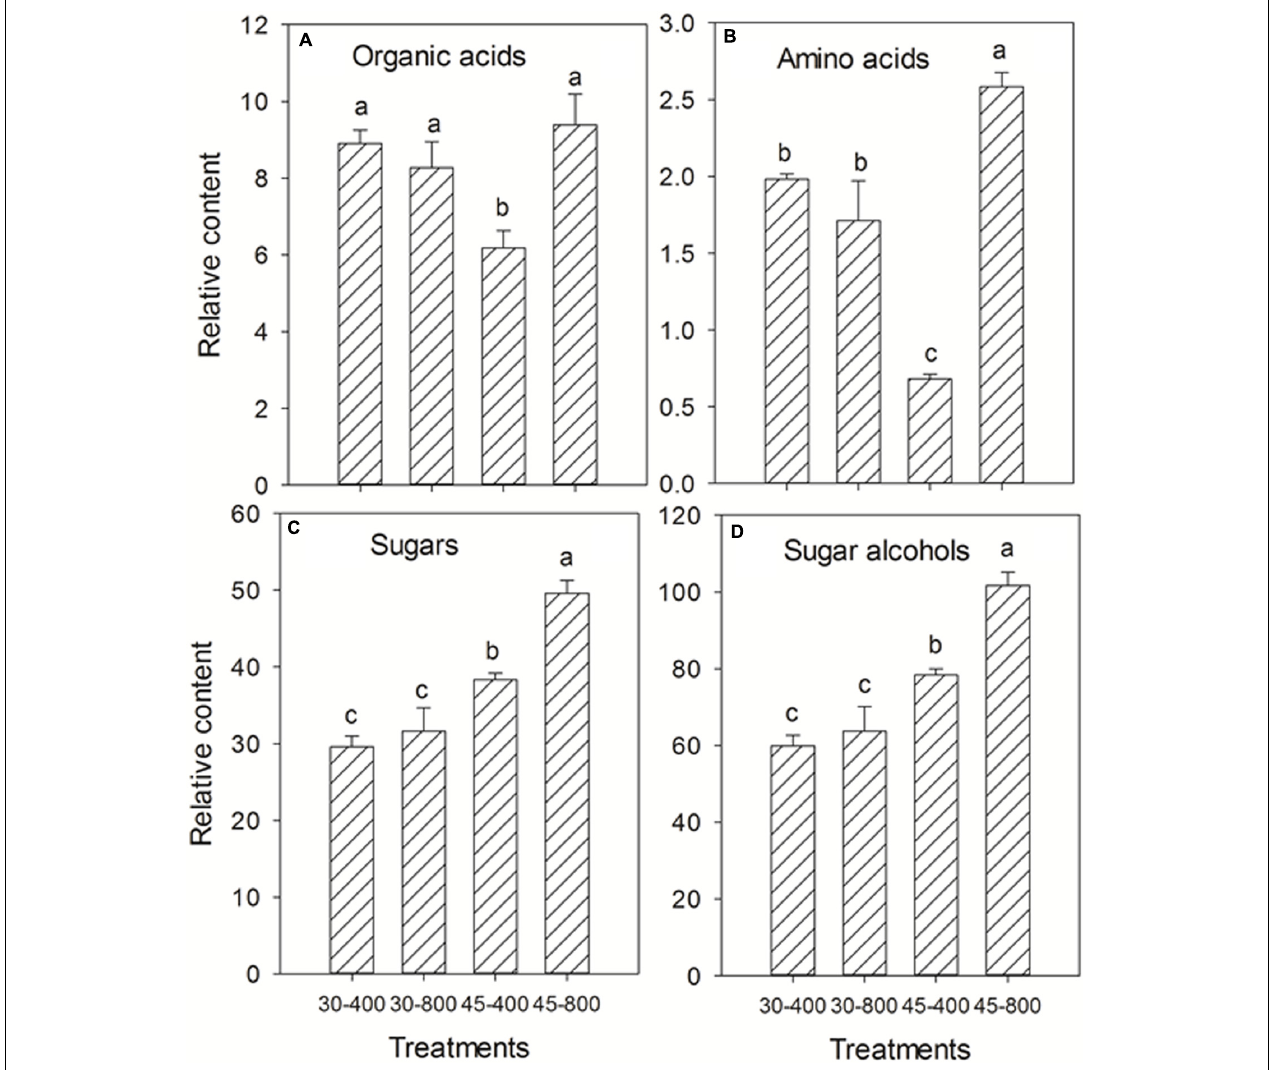
FIGURE 3 | Effects of elevated CO 2 concentration on total content of organic acids (A) , amino acids (B) , sugars (C) , and sugar alcohols (D) in response to heat stress in bermudagrass. The treatments symbols are 30 and 45 for normal temperature control and heat stress and 400 and 800 for ambient CO 2 and elevated CO 2 concentrations,